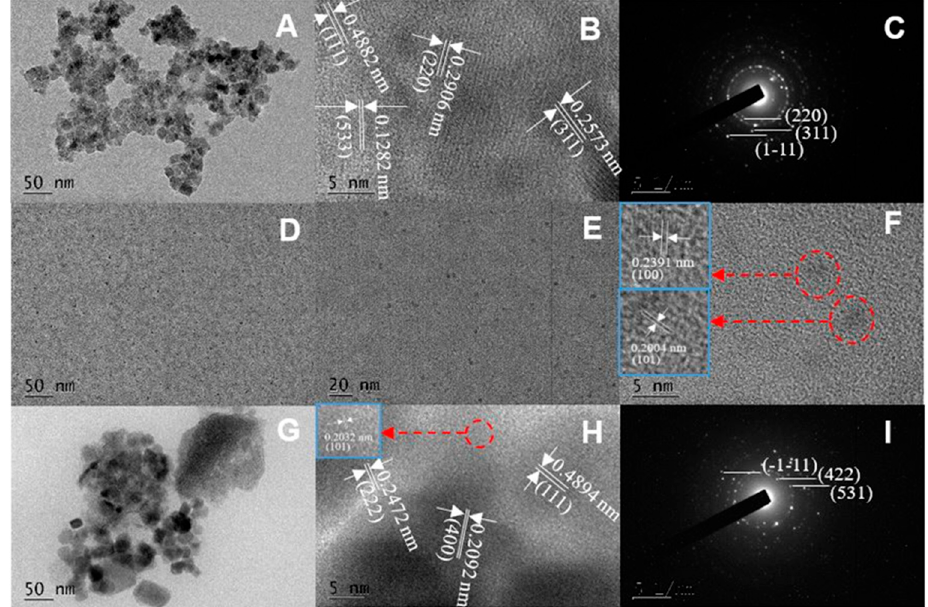
Figure 2. The TEM, HRTEM, and SAED images of CoFe 2 O 4 ( A – C ); the TEM images of PCPS ( D , E ) and HRTEM ( F ); the TEM, HRTEM, and SAED images of CoFe 2 O 4 /PCPS ( G – I ).